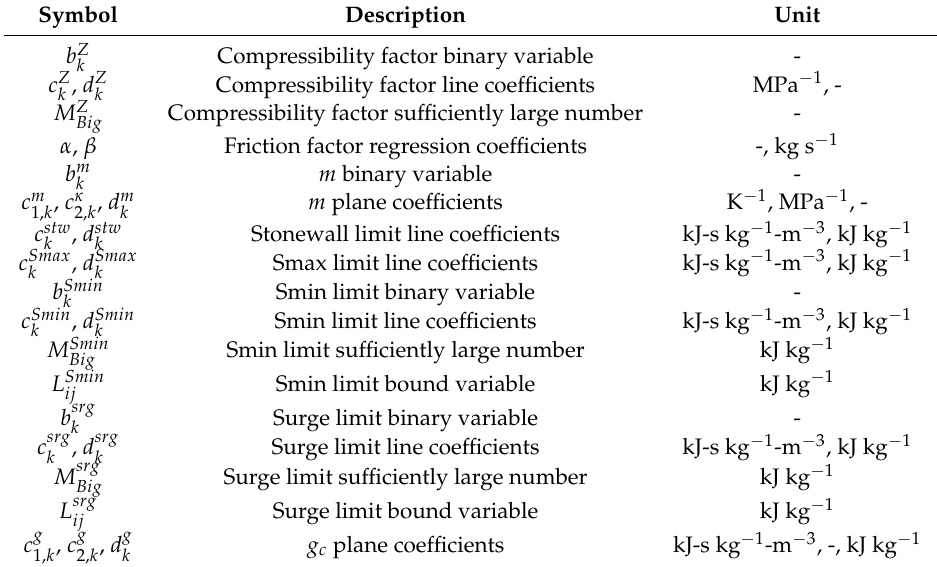
Table 2. Parameters and variables for implementing the approximations into the Fuel Cost Minimization Problem (FCMP)